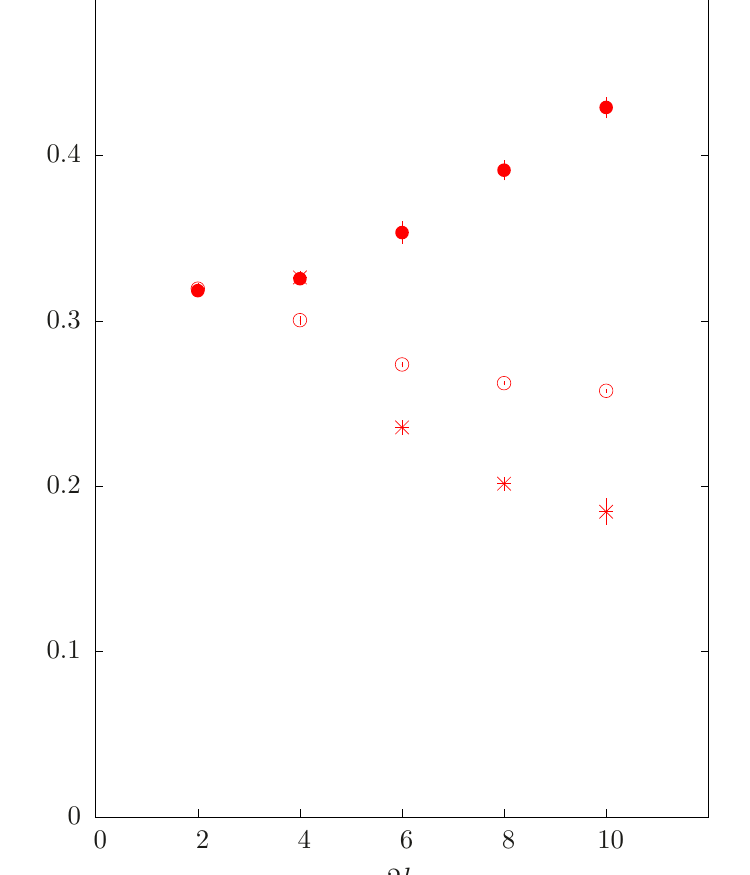
, and Pfa(cid:14)ans, , of (cid:13)ux loop operators in (cid:14) (cid:15)